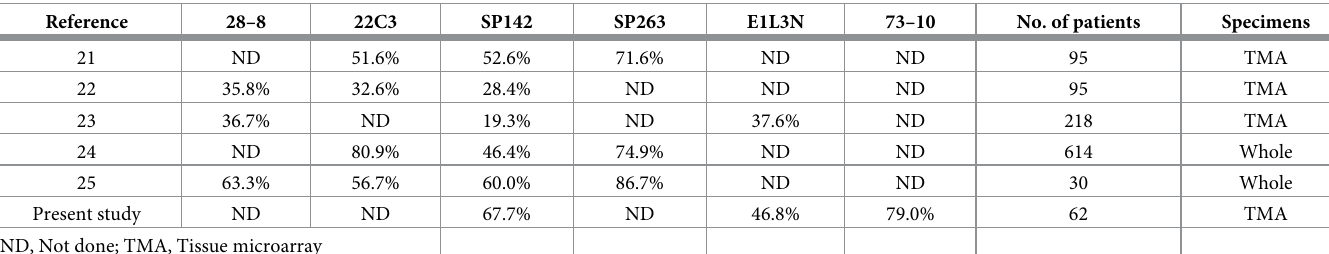
Table 8. Comparison of PD-L1 expression among different primary